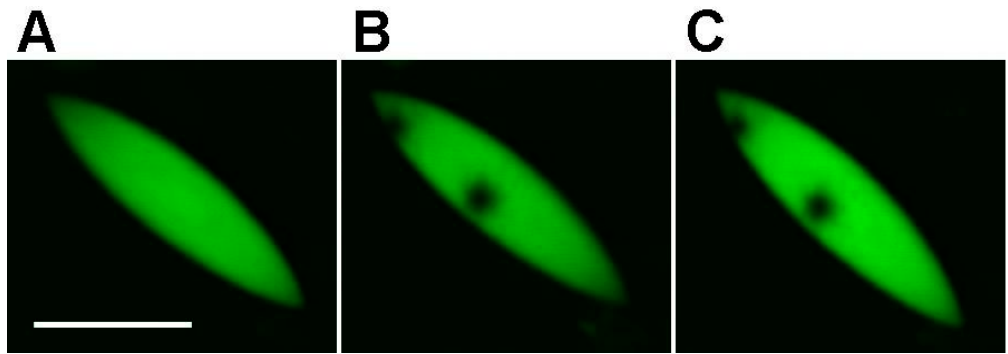
Figure 7. FRAP analysis of a green FP granule in Zoanthus tissues. ( A ) Before bleaching; ( B ) immediately after bleaching by 488 nm laser at the two points; ( C ) in 30 min after bleaching. Scale bar − 10 µm.